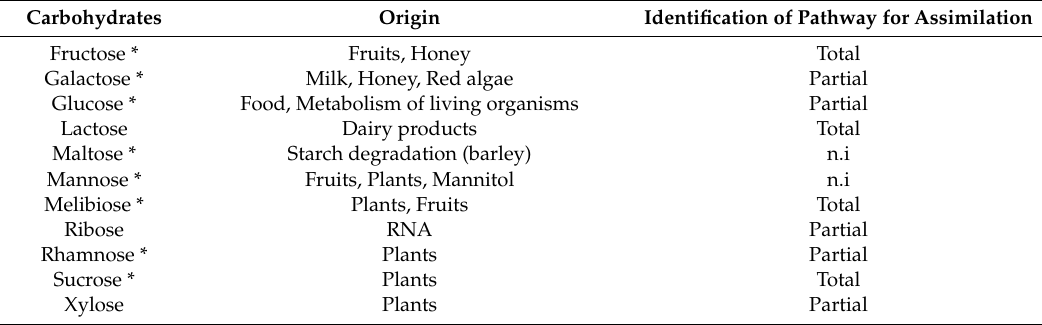
Table 3. Listing of common carbohydrates used for PHA production.